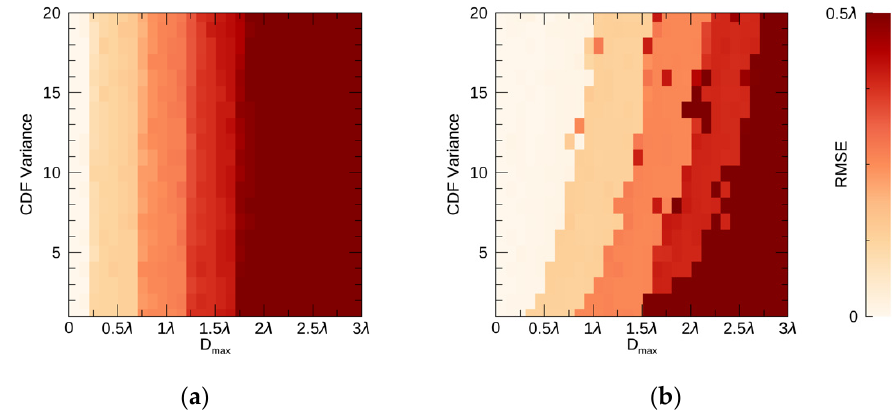
Figure 5. ( a ) The root mean square error (RMSE) distribution with the ConvPSI; and ( b ) the RMSE distribution with the NN-PSI. The vertical axis shows the CDF variance, and the horizontal axis shows the D max .